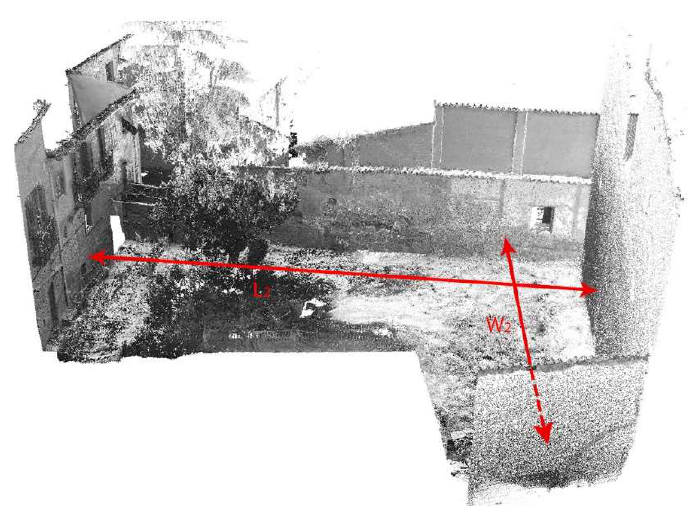
Figure 14. Distances measured for the accuracy evaluation.